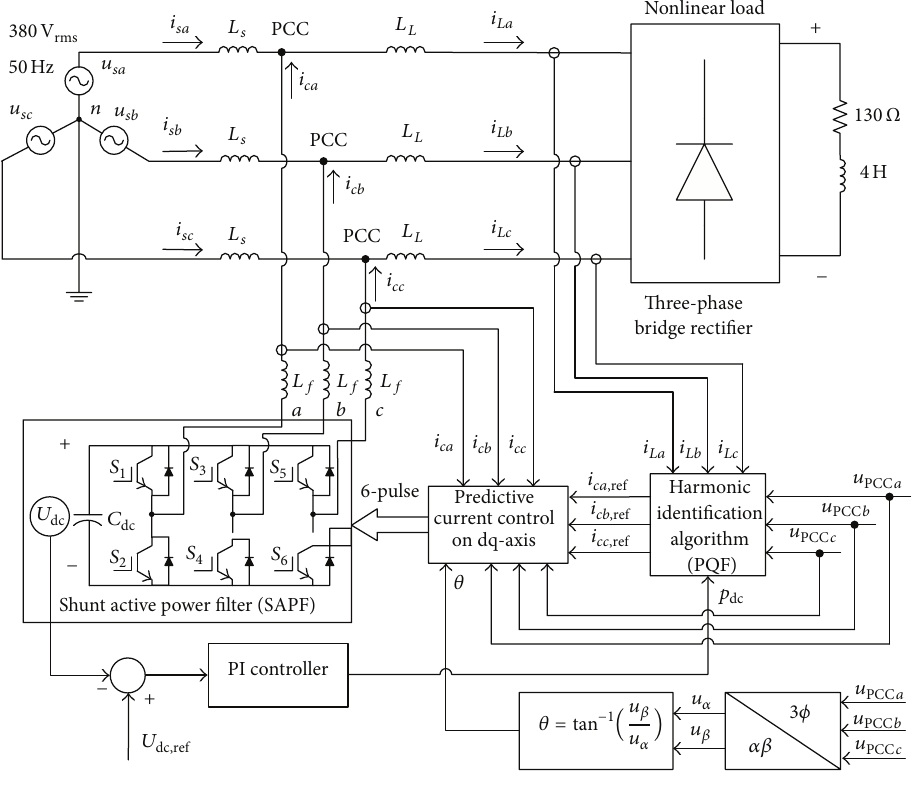
Figure 9: The balanced power system with the predictive current control of SAPF.